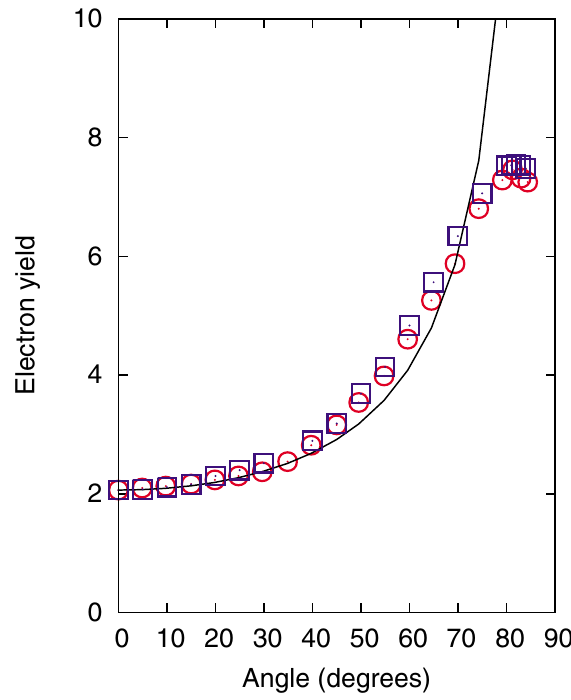
FIG. 5. (Color) The measured (red circles) and simulated (blue squares) electron yields as a function of angle of incidence of the ion measured from the surface normal for 0.04 MeVargon (cid:2) 35 (cid:3)A . The simula- hitting copper. The simulations used d esc tion values are normalized to match the measured yield at the least grazing angle ( 0 (cid:10) in this case). The rms difference between simulated and measured yield is 3.0%. Equation (9) (cid:1) 78 : 9 (cid:10) for these parameters. The peak in the experi- gives (cid:10) c mental and simulation results occurs at 83 : 0 (cid:10) . The solid line is inverse cosine